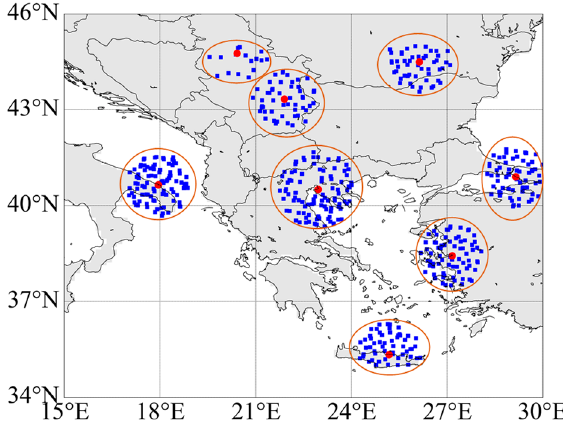
Figure 12. Schematic diagram of sounding sites and matching satellite observations.